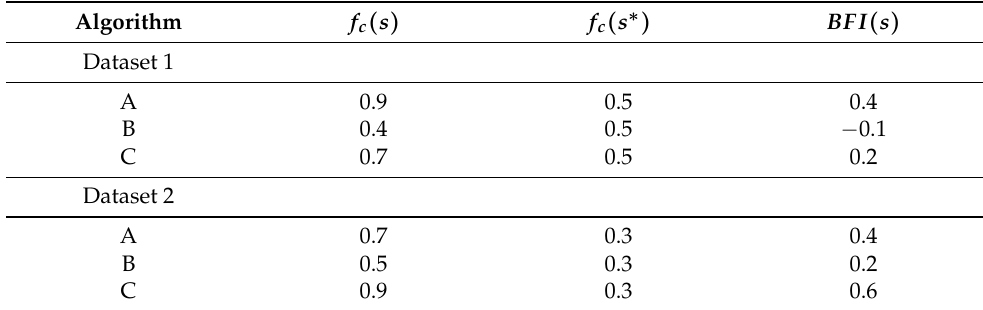
Table 1. Artificial baseline fitness improvement (BFI) and